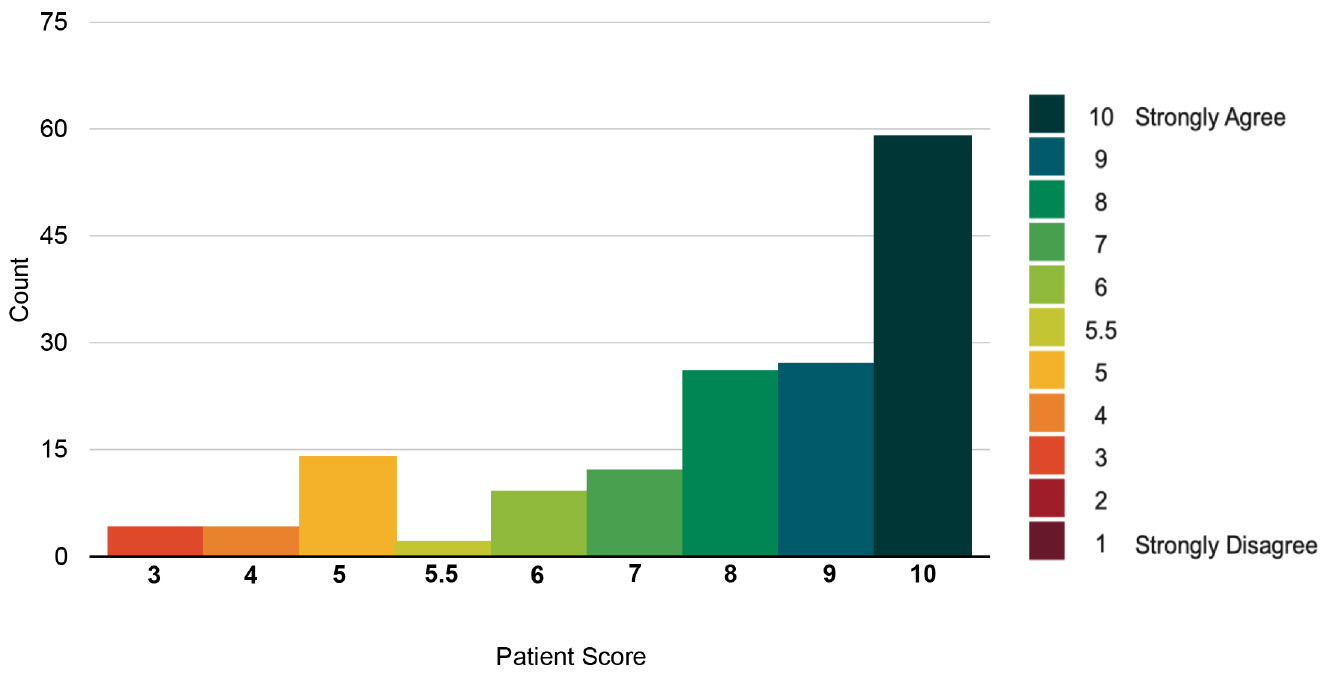
Figure 1 Histogram showing distribution of scores that patients provided regarding their agreement with the statement 'Overall, I had a very good experience of the Living Well Assessment' . A Mann–Whitney U - test concluded that scores for agreement with this statement did not differ with age group (dichotomised), U = 2756, P = 0.63. Nor did the scores differ by sex, U = 2527, P = 0.34. A Kruskal–Wallis test found no association between patient score and method of assessment, χ 2 (2) = 0.80, P = 0.67. Patient agreement and time of assessment were not associated either, χ 2 (3) = 1.89, P